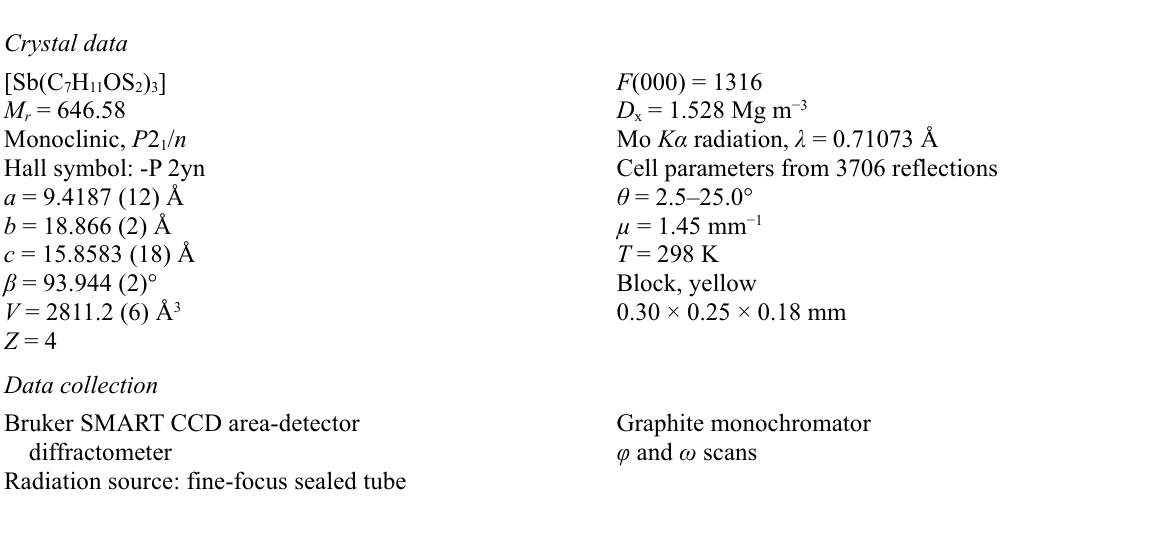
Packing diagram of the title compound viewed approximately along the a axis. H atoms are omitted for clarity. Tris( O -cyclohexyl dithiocarbonato- κ S